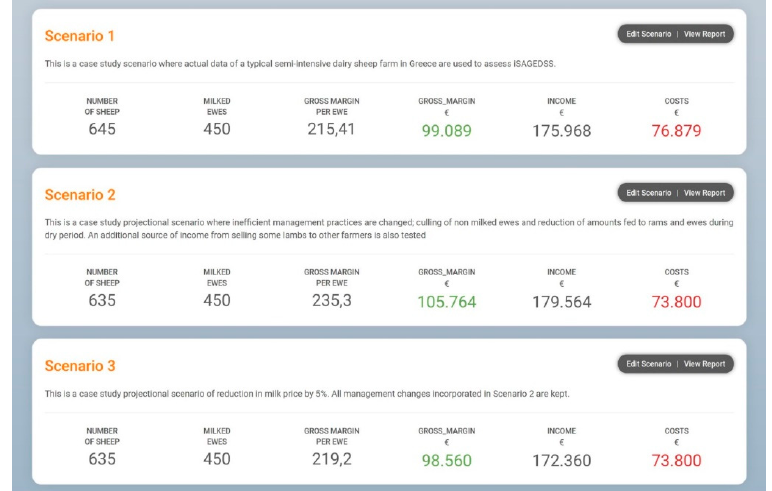
Figure 9. Comparison of the basic financial outputs of Scenarios 1, 2 and 3 from the case study dairy sheep Farm A, in Greece; decimal comma is used as the decimal separator.